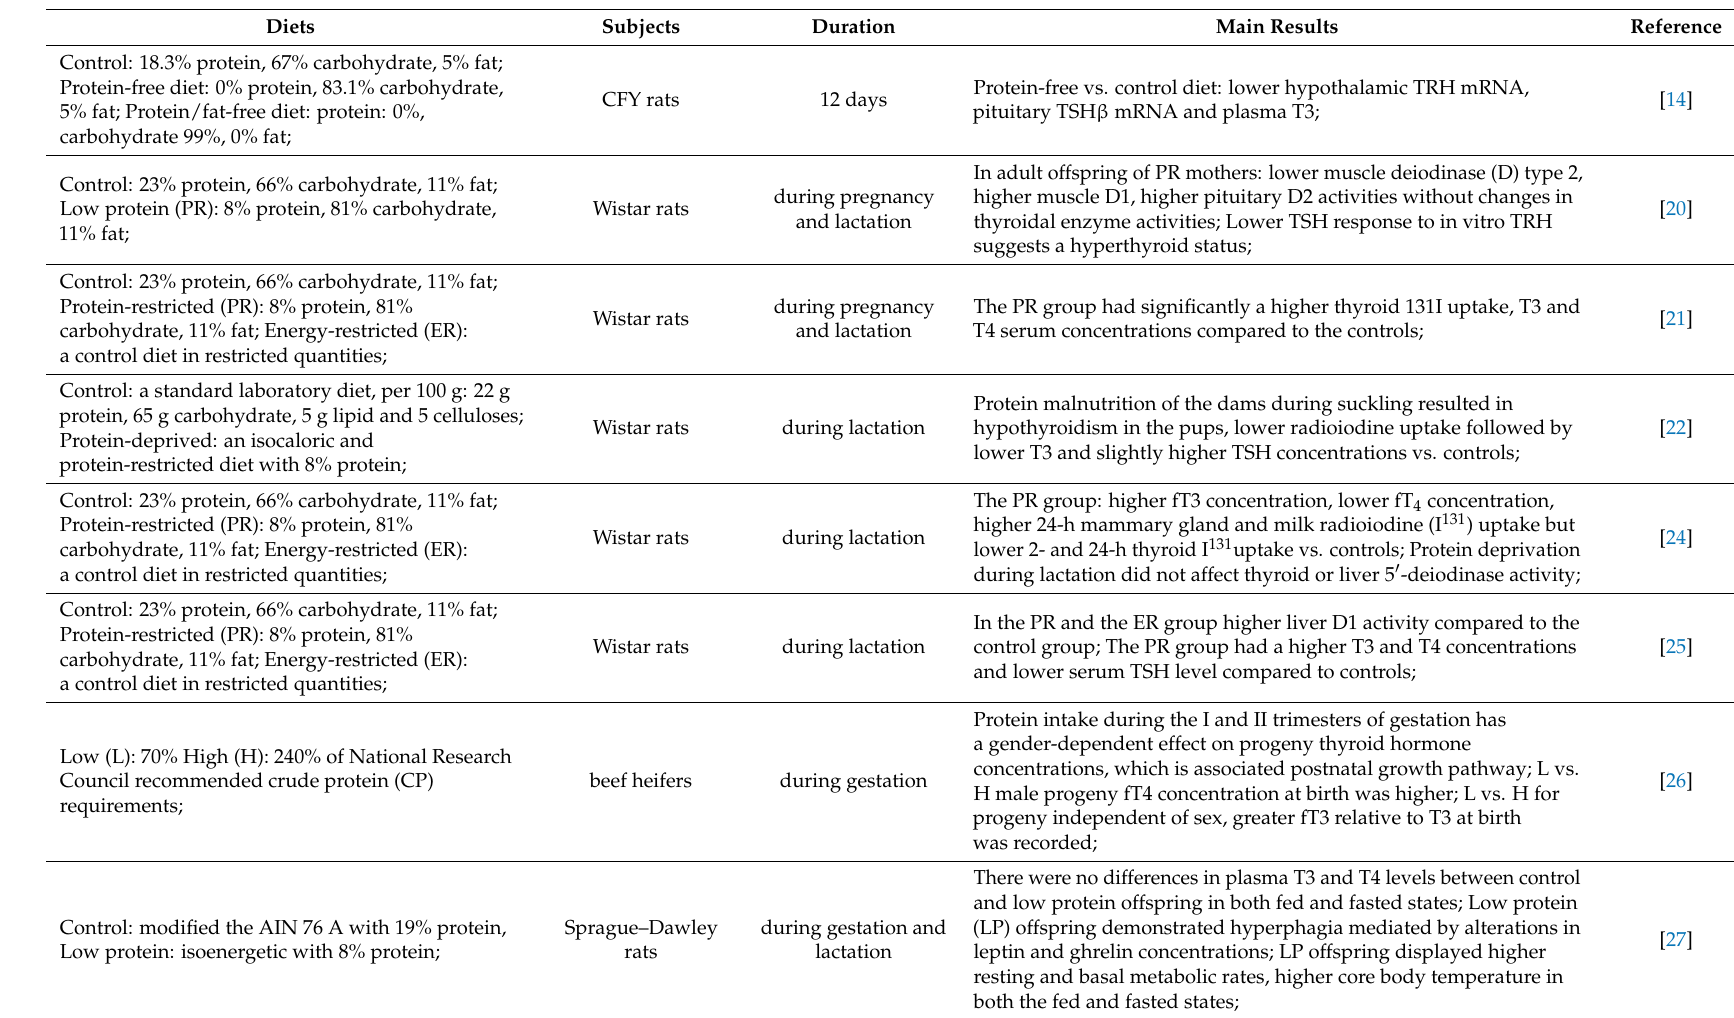
Table 1. Summary of selected studies investigating the effect of protein quantity on HPT axis activity. Diets Subjects Main Results